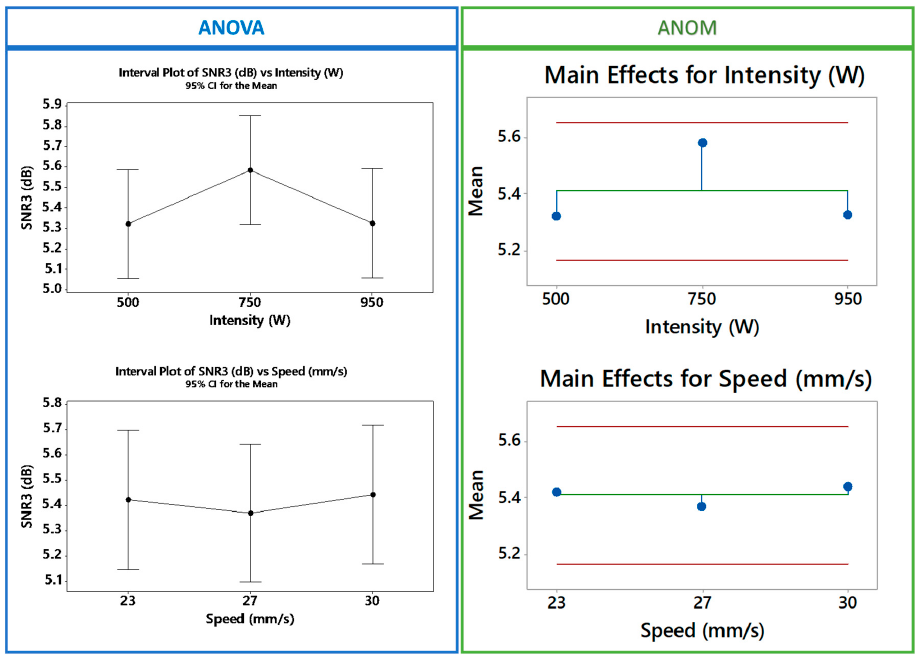
Figure 5. ANOM/ANOVA analyses for Factor A and B using Minitab.